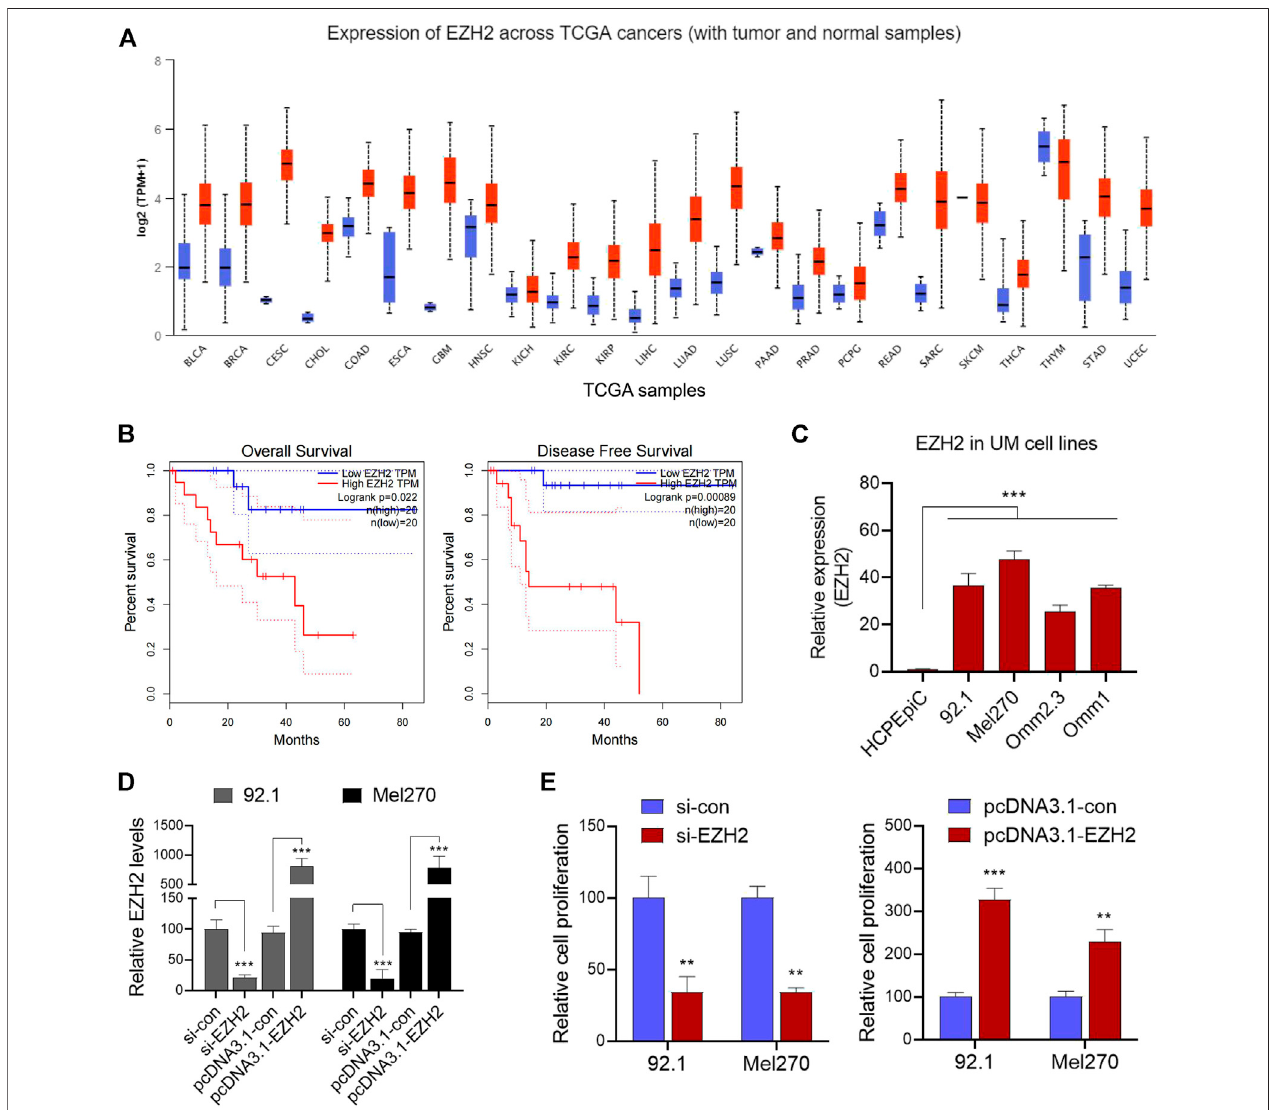
FIGURE 1 | EZH2 was upregulated and promoted tumor proliferation in UM. (A) In various tumor types of the TCGA dataset, UALCAN analysis was used to reanalyze the levels of EZH2. (B) The correlations between the expression of EZH2 and overall survival (OS) and disease-free survival (DFS) were further analyzed in patients with UM. (C) Relative levels of EZH2 expression in the UM cell lines and a human choroid plexus epithelial cell line (HCPEpiC) were measured. (D) After the knockdownofEZH2bysiRNA,oroverexpressionofEZH2,relativeEZH2levelsweredeterminedin92.1andMel270cells. (E) Cellviabilitiesinbothcellgroupswere evaluated. ** p < 0.01, *** p < 0.001. Abbreviations: EZH2, enhancer of zeste homolog 2; UM, uveal melanoma; TGGA, The Cancer Genome